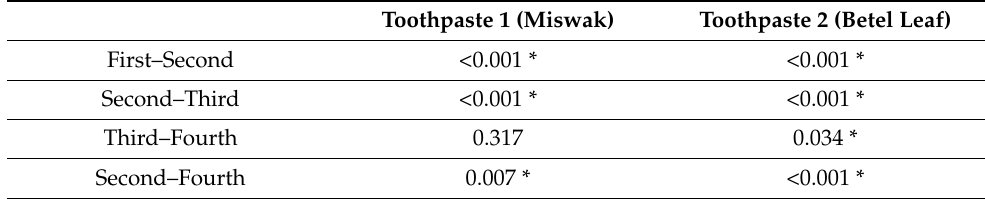
Table 4. Comparison of bleeding score between the time points in each